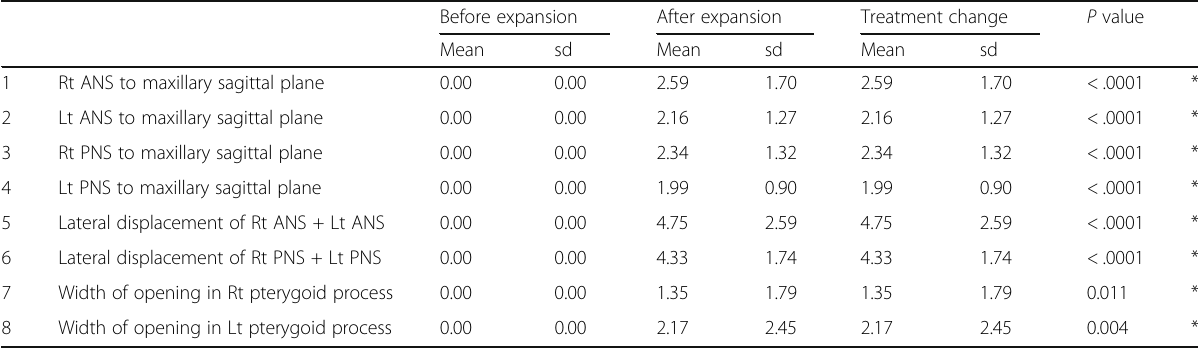
Table 2 Results for lateral displacement of ANS and PNS and width of opening in pterygoid processes